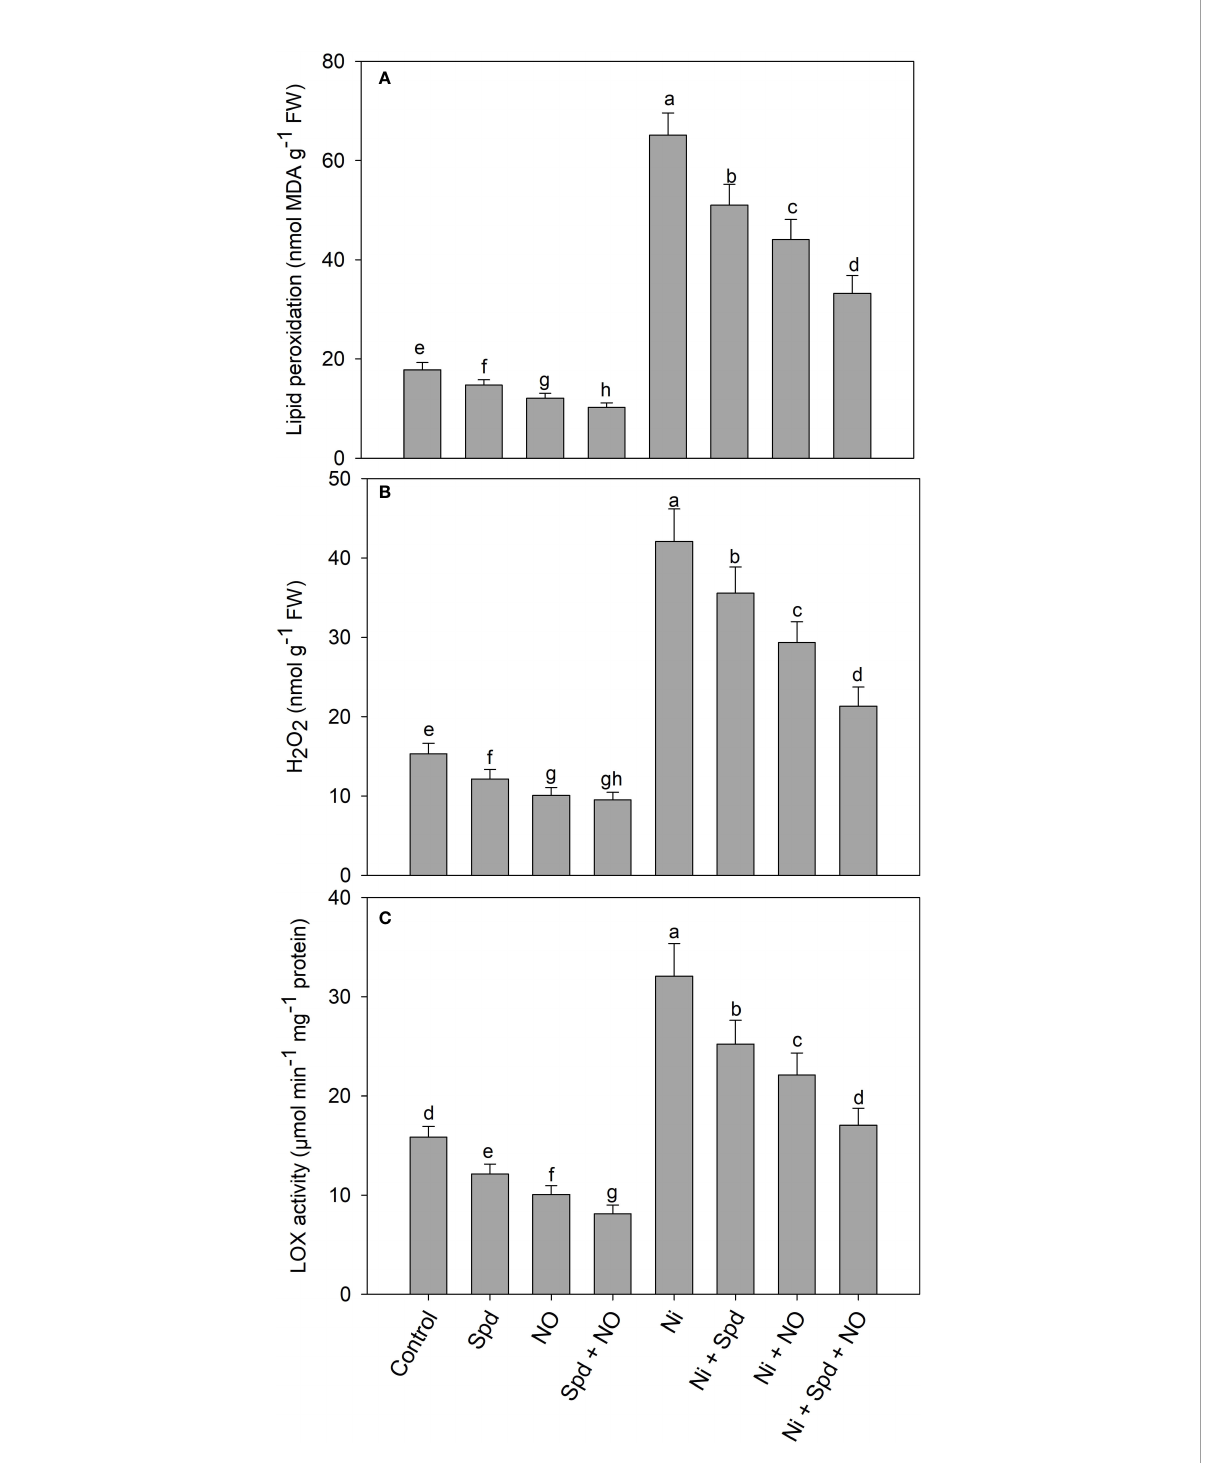
FIGURE 4 Effect of nitric oxide (50 µM) and spermidine (100 µM) supplementation on (A) lipid peroxidation, (B) hydrogen peroxide and (C) activity of lipoxygenase in Solanum lycopersicum L. subjected to nickel stress. Data is mean (±SE) of four replicates and different letters on bars denote signi fi cant difference at P <